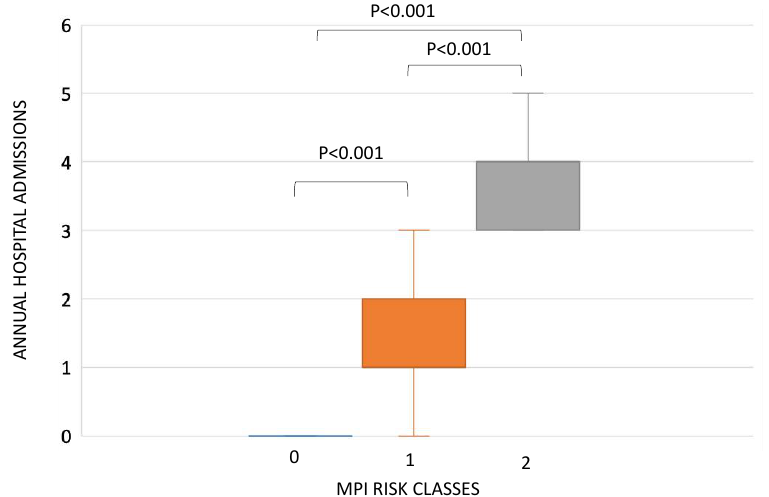
Figure 1. Correlation between the multidimensional prognostic index (MPI) score and days of hospitalization over the 24-month follow-up. ( r = 0.801, p <0.00001). According to MPI risk classes, the mean of annual hospital admissions was different between the three MPI grades ( p < 0.001) (Figure 2). In particular, patients in MPI risk class 2 showed a significantly higher median number of hospitalizations per year (4, IQR 3; 4) with respect to patients in MPI risk class 1 (1, IQR 1; 2) ( p < 0.0001) and to those in MPI risk class 0 (0, IQR 0; 0) ( p < 0.0001) as well as a higher median number of hospitalizations per year between patients in MPI risk class 1 versus those with risk 0 ( p < 0.0001) (Figure 2). These significant differences between MPI risk classes were confirmed when considering separately CKD patients in non-replacement therapy ( p < 0.0001), and when considering CKD patients in replacement therapy only ( p < 0.0001).